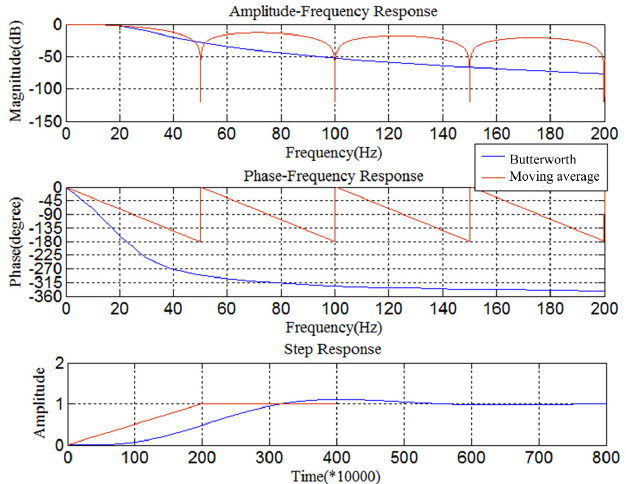
Figure 6. The frequency response and step response of the moving average filter and Butterworth low-pass filter.